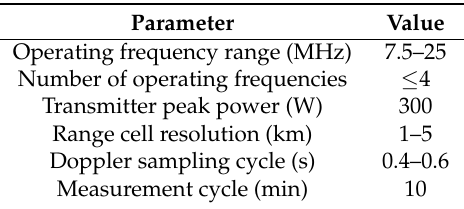
Figure 2. The setup of receiving antennas of multi-frequency HF (MHF) radar. The blue dots represent the positions of eight antennas. Table 1. Capabilities of the MHF Radar